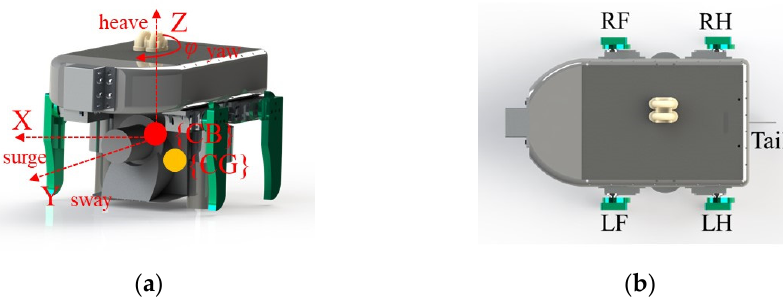
Figure 8. The bio-inspired son underwater robot: ( a ) relative positions of CB and CG; ( b ) exterior of the proposed son underwater robot. The right foreleg, right hind leg, left foreleg, and left hind leg are indicated by RF, RH, LF, and LH, respectively.